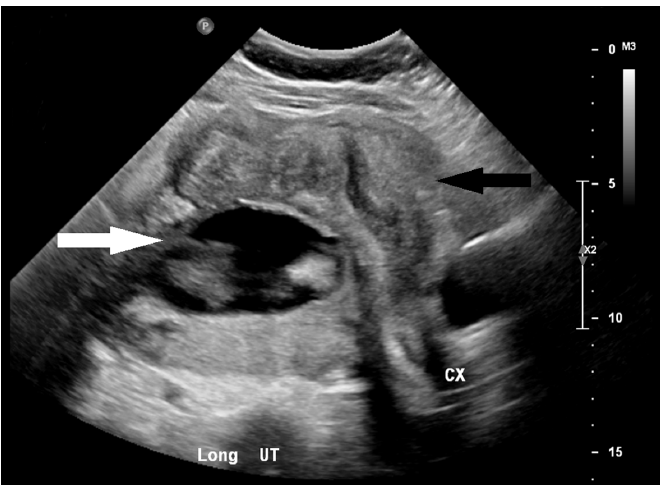
Image 2. Longitudinal image of the uterus (UT) is depicted by the black arrow. The gestational sac is seen sitting posterior to the uterus and is depicted by the white